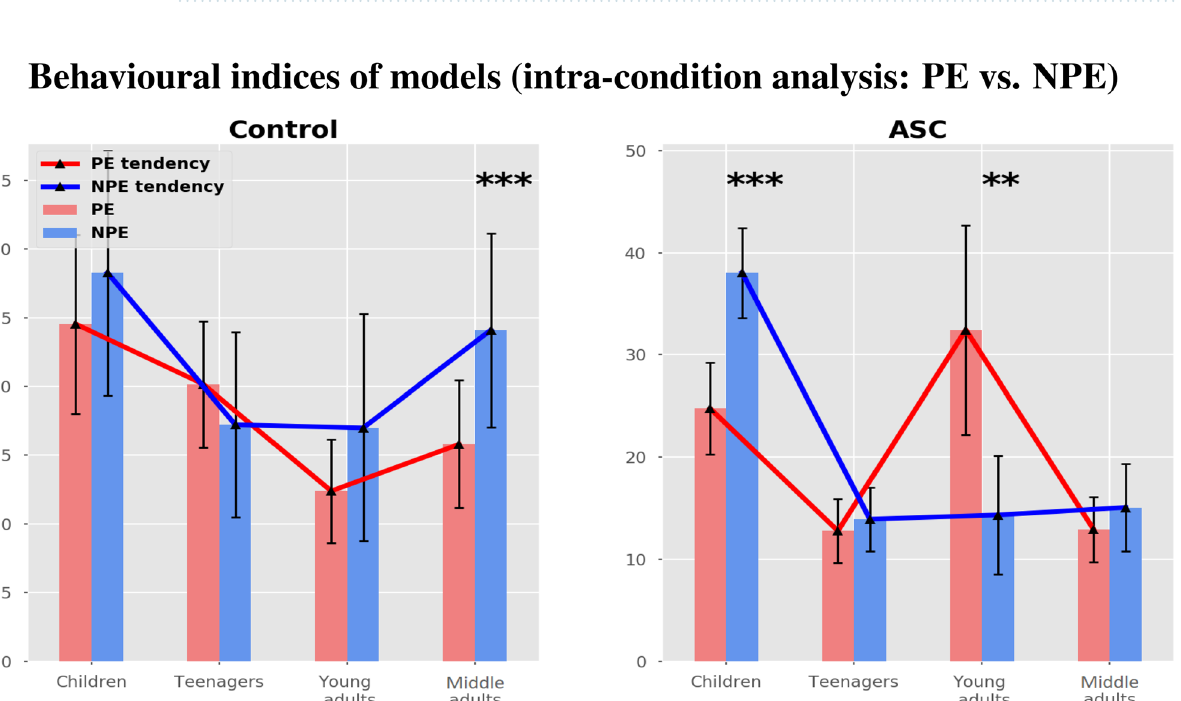
Table 3. Behavioural indices of the models that produce the best fit of the data from participants.